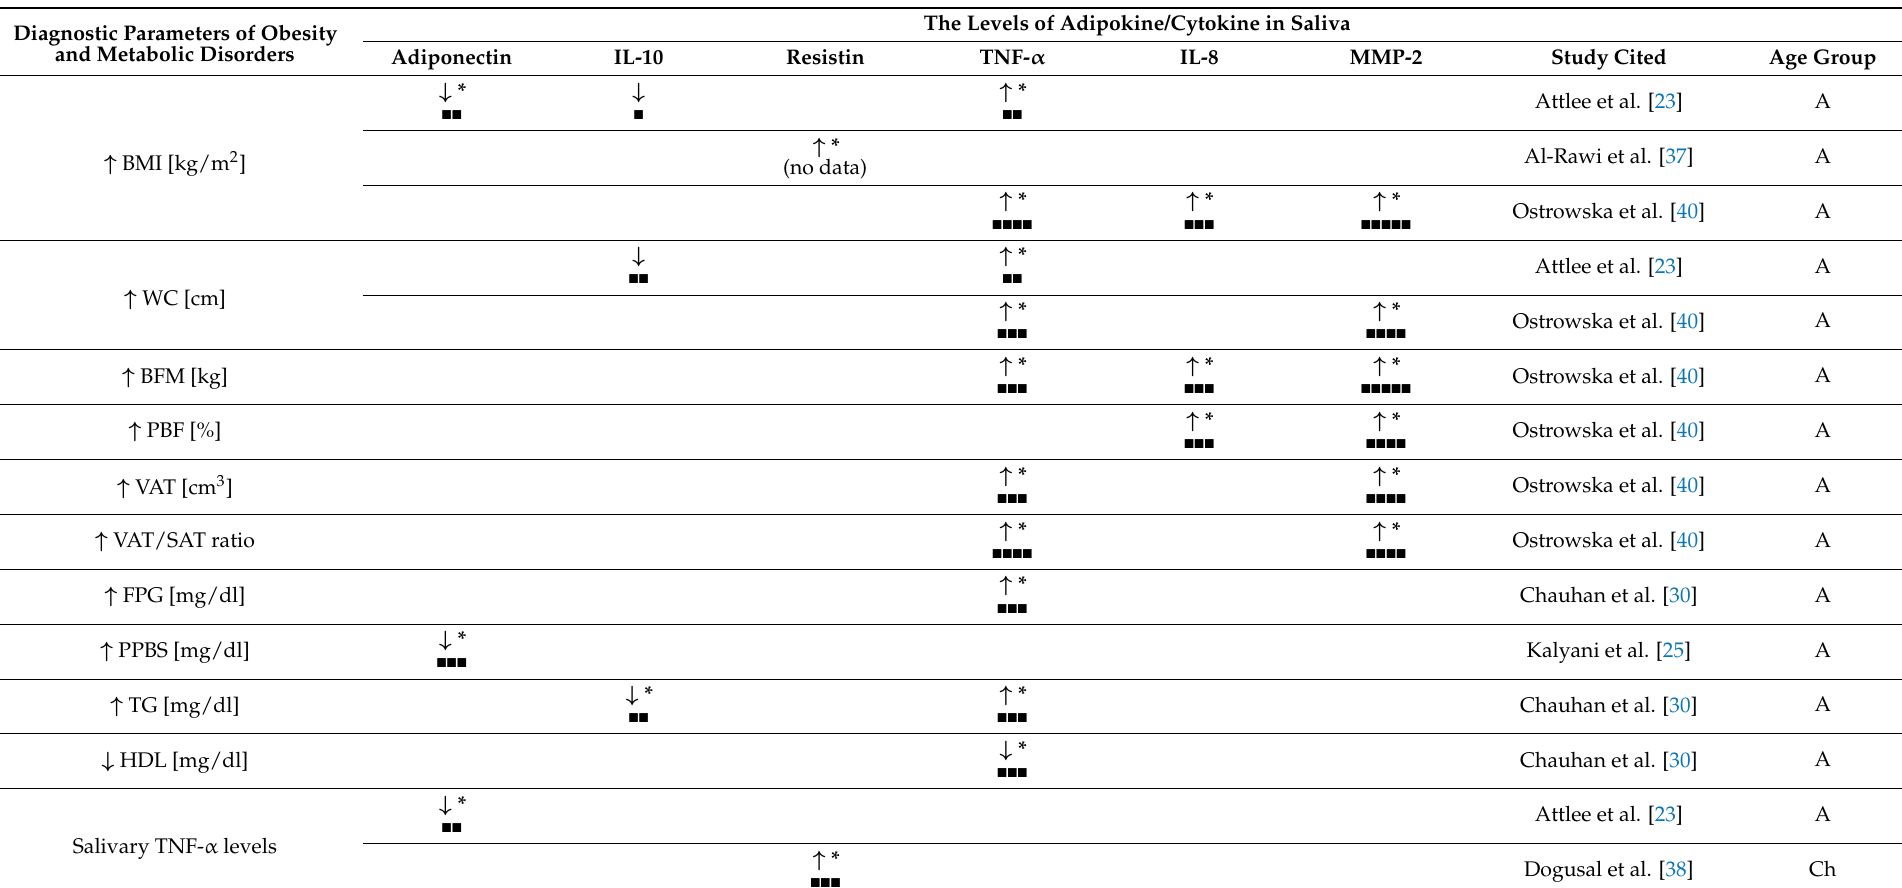
Table 1. Summary of the studies cited in the review, which showed a correlation between the levels of selected adipokines and cytokines in saliva and the diagnostic parameters of obesity and its accompanying metabolic